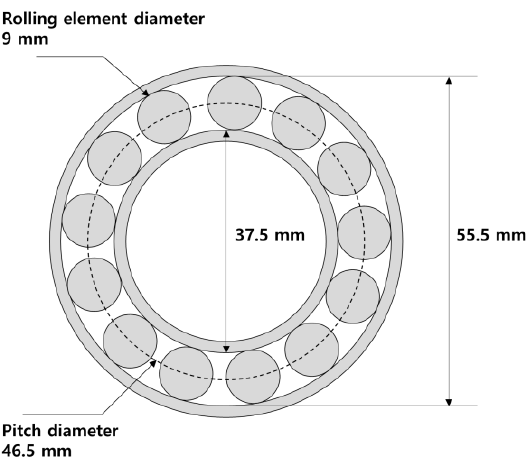
Table 2. The specification of the target bearing, FAG NJ206-E-TVP2.